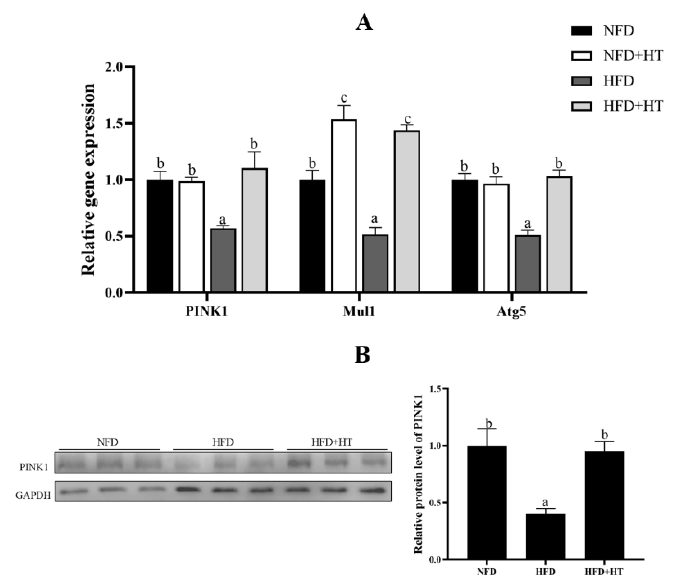
Figure 5. Relative gene expression of mitophagy-related genes ( A ) and protein level of PINK1 ( B ) in the liver of L. maculatus fed the test diets for 8 weeks. All values are exhibited as mean ± SE. The values with different superscripts (a, b, c) are significantly different at p < 0.05 (Tukey’s test).